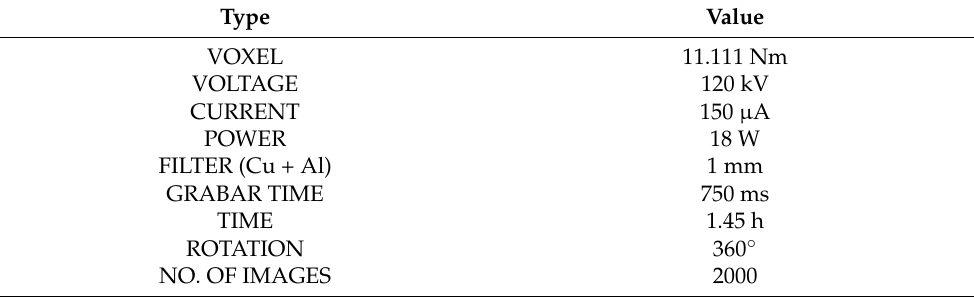
Table 1. Nano-CT